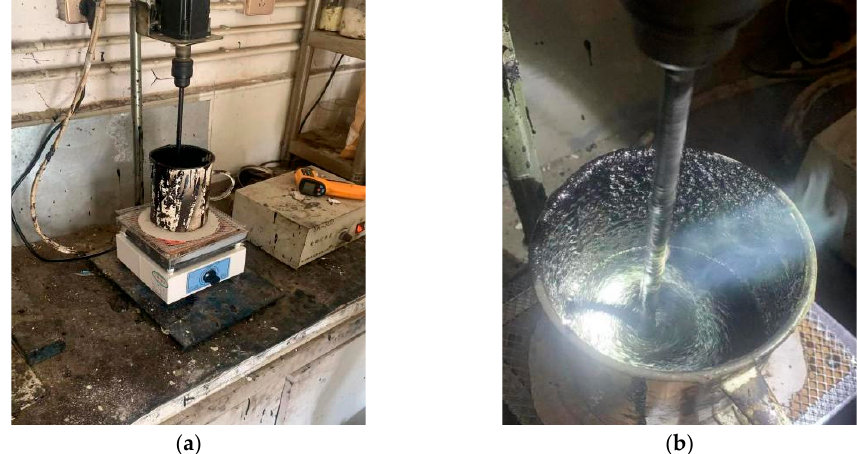
Figure 2. The mixing process of the mortar and powder: ( a ) Heating by electric furnace; ( b ) Mixing by stirrer.